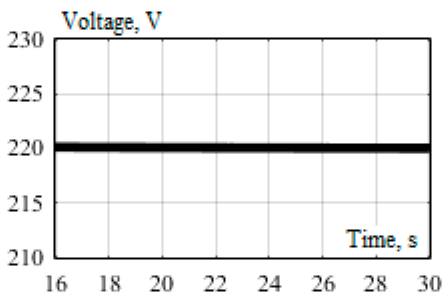
Figure 10. Graph of voltage on the LV side of PR (DC grid) .